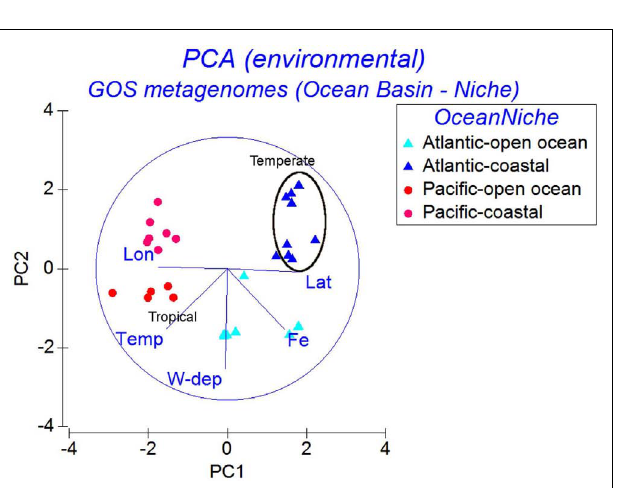
FIGURE 5 | Principal ComponentsAnalysis of GOS samples using similarities of the environmental parameter profiles. The samples are labeled according to the ocean basins (Atlantic or Pacific) combined with niche groups (Open Ocean or